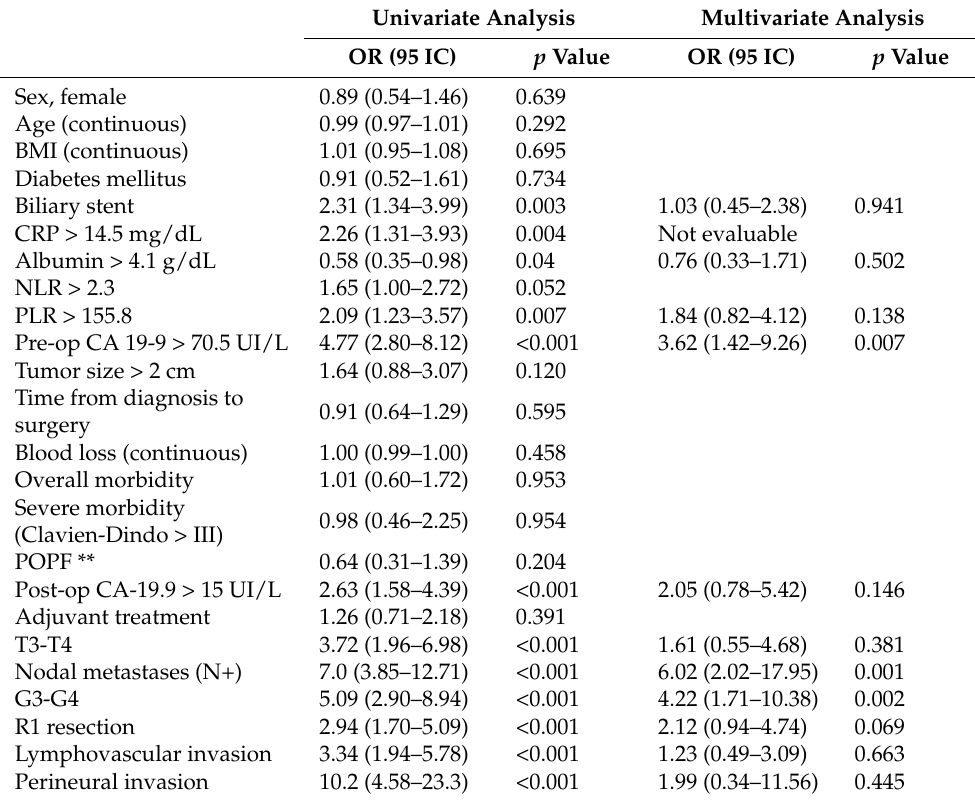
Table 4. Univariate and multivariate analysis of predictive factors of recurrence. Univariate Analysis